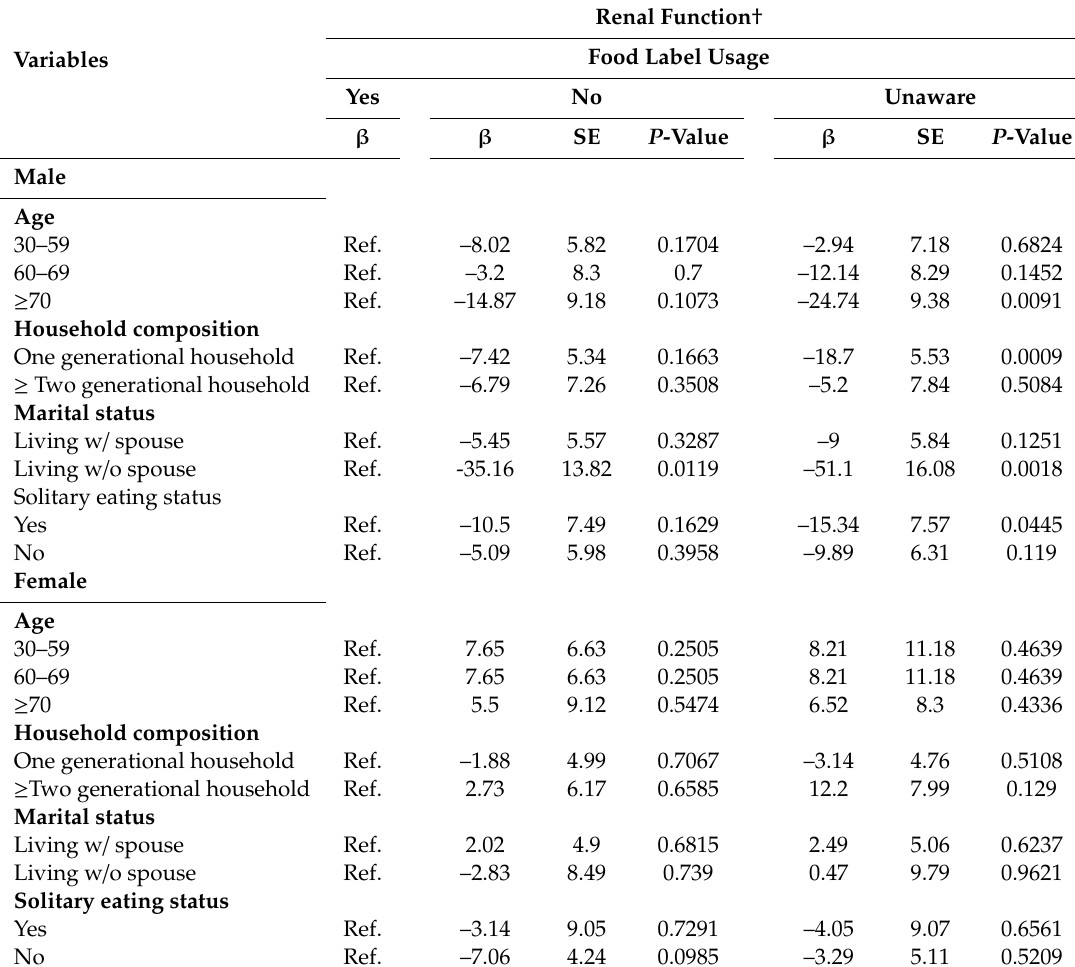
Table 3. Subgroup analysis stratified by age, household composition, marital status, and solitary eating